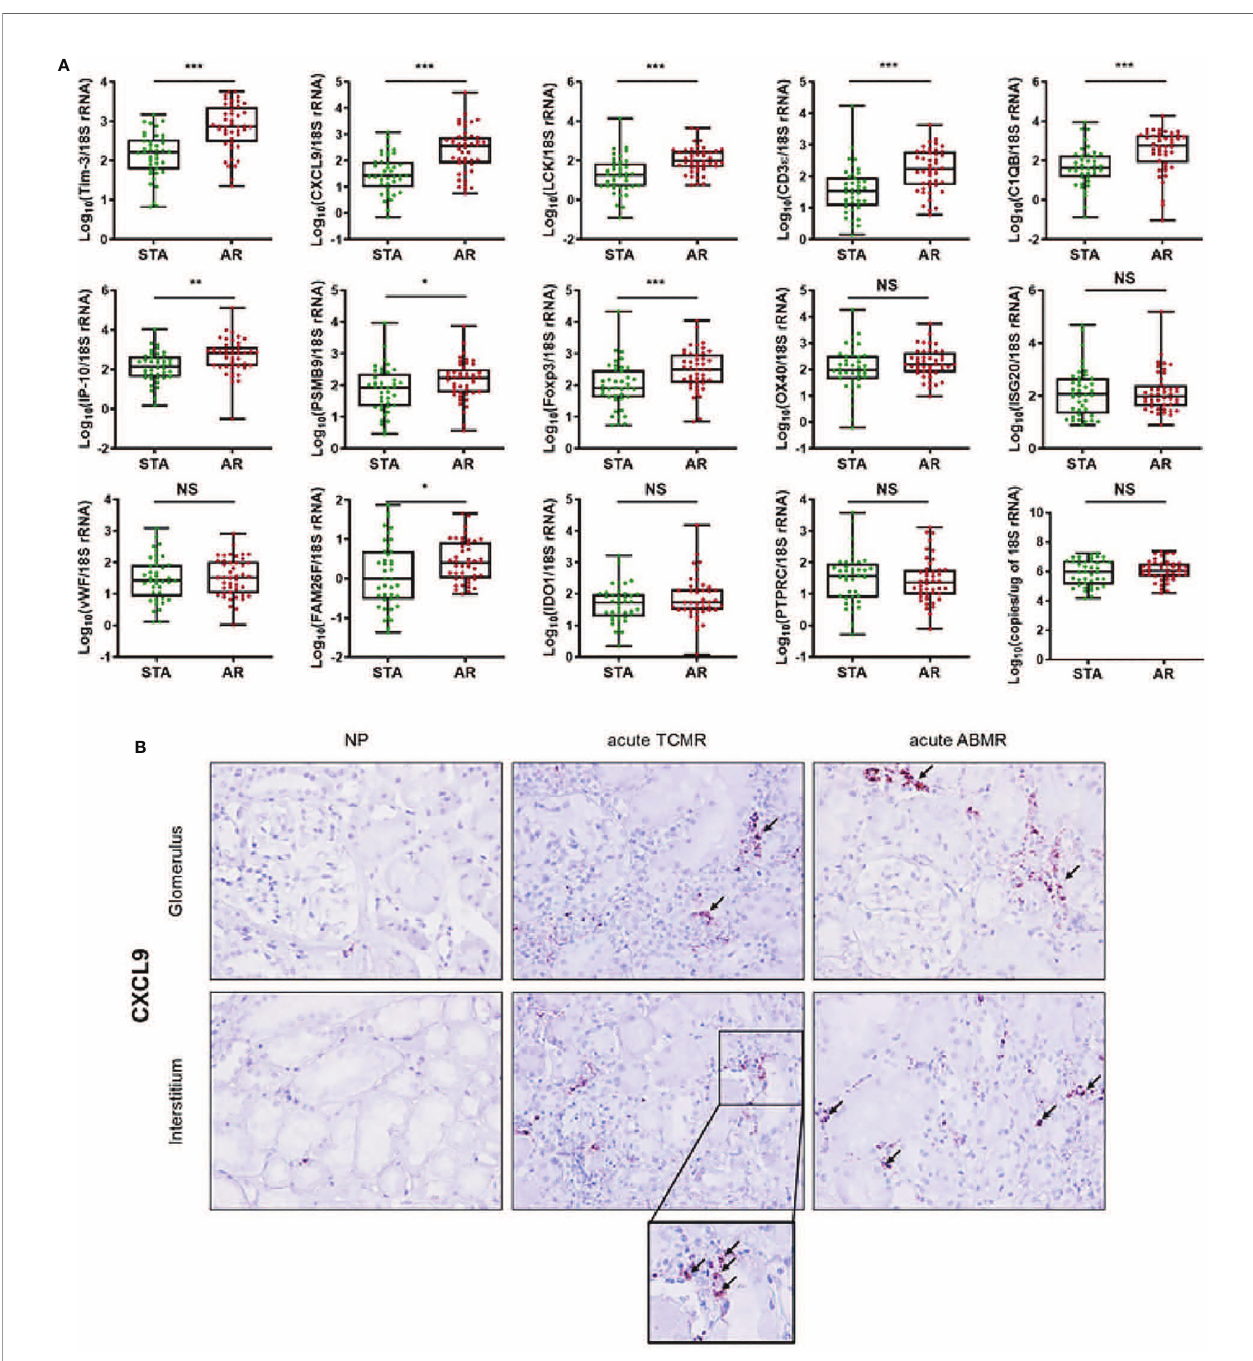
FIGURE 2 | The expression levels of each mRNA between STA (n=45) and AR (n=58) were analyzed using absolute quantitative qPCR without pre-ampli fi cation. Each mRNA level was log10-transformed after each mRNA copy number was normalized with 18S rRNA copies (x10-6) in the QC-passed samples (STA, n=40; AR, n=44). (A) The levels of CXCL9, IP-10, C1QB, PSMB9, LCK, CD3 e , Foxp3, FAM26F, and Tim-3 mRNAs were signi fi cantly elevated in AR compared to STA, and for OX40, ISG20, vWF, IDO1, and PTPRC mRNAs, there was no difference. In the 18s rRNA used as an endogenous control, there was no difference between AR and STA. P values by the non-parametric Mann-Whitney test were expressed as the mean ± SE. NS: not signi fi cant, *P < 0.05, **P < 0.01 and ***P < 0.001 versus STA. Although LCK, Foxp3, and FAM26F mRNAs were statistically signi fi cant, these mRNAs were not detected in more than 10% of the QC-passed samples. Therefore, we excluded these mRNAs for further analysis. (B) CXCL9 mRNA expression in kidney biopsy tissues of NP, acute TCMR and acute ABMR groups was examined by ISH (original magni fi cation x400). CXCL9 was distinctly expressed in the damaged tubules in kidney allografts of acute TCMR and predominantly in the peritubular capillary area in ABMR groups (black arrows). Scale bars: 50 m